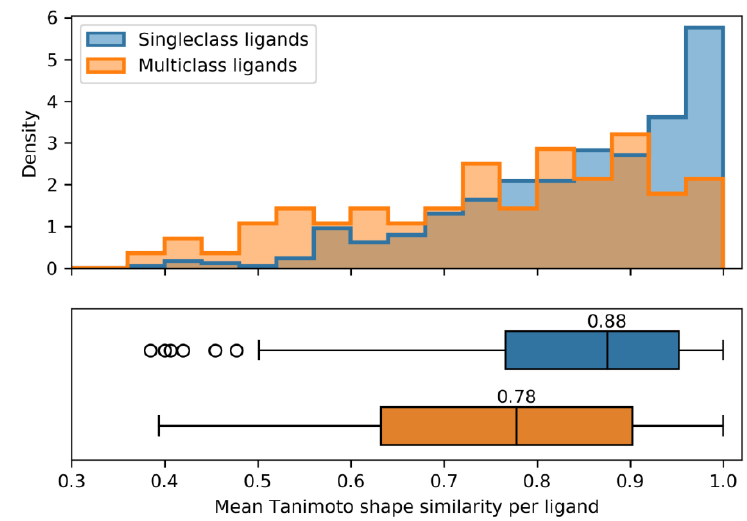
Figure 4. Shape similarity of MCLs versus SCLs. Histograms (top) and boxplots (bottom) report the distribution of shape similarity values of MCLs and SCLs on the same scale. For each ligand, shape similarity was calculated as mean of pairwise comparisons of binding modes across all targets. Boxplots show the lower quartile (left boundary of the box), median value (vertical line), and upper quartile (right boundary of the box). Additionally, whiskers indicate the 1.5-fold of the interquartile range. Statistical outliers are depicted as